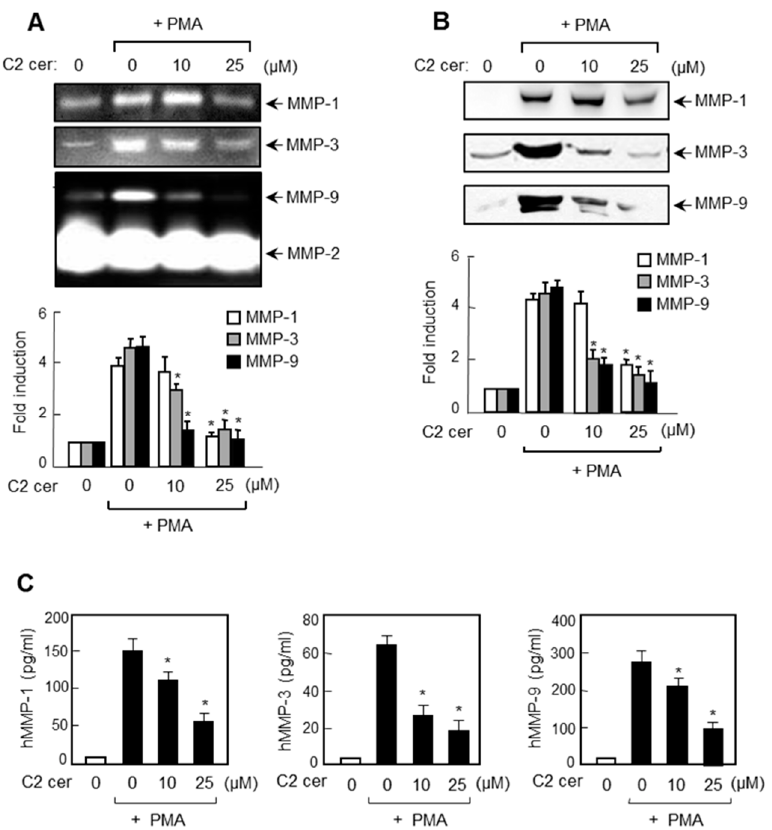
Figure 2. C2 ceramide inhibits the protein expressions of MMP-1, -3, and -9 in U87MG cells. ( A ) Cells were treated with C2 ceramide in the presence of PMA in serum free media for 24 h. The conditioned media were analyzed by gelatin zymography (detection of MMP-1, -2, and -9) and casein zymography (detection of MMP-3); ( B ) Western blot analysis for MMP expressions in the conditioned media using antibodies against MMP-1, -3 and -9. The fold inductions of each MMP protein level are shown in the bottom panel; and ( C ) U87MG glioma cells were treated with C2 ceramide in presence of PMA for 24 h. The levels of MMP-1, -3, and -9 secreted in the medium were analyzed through enzyme-linked immunosorbent assay (ELISA). Data correspond to the mean ± S.E.M. of three independent experiments. * p < 0.05; significantly different from the PMA treated sample.